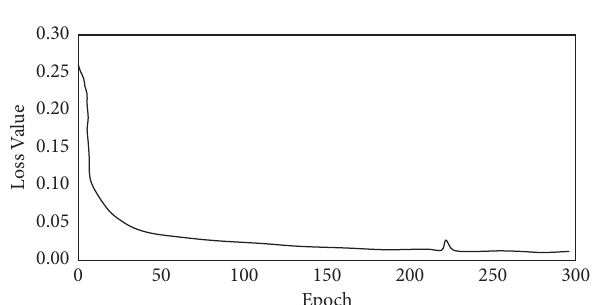
Figure 6: Loss value of loss function.